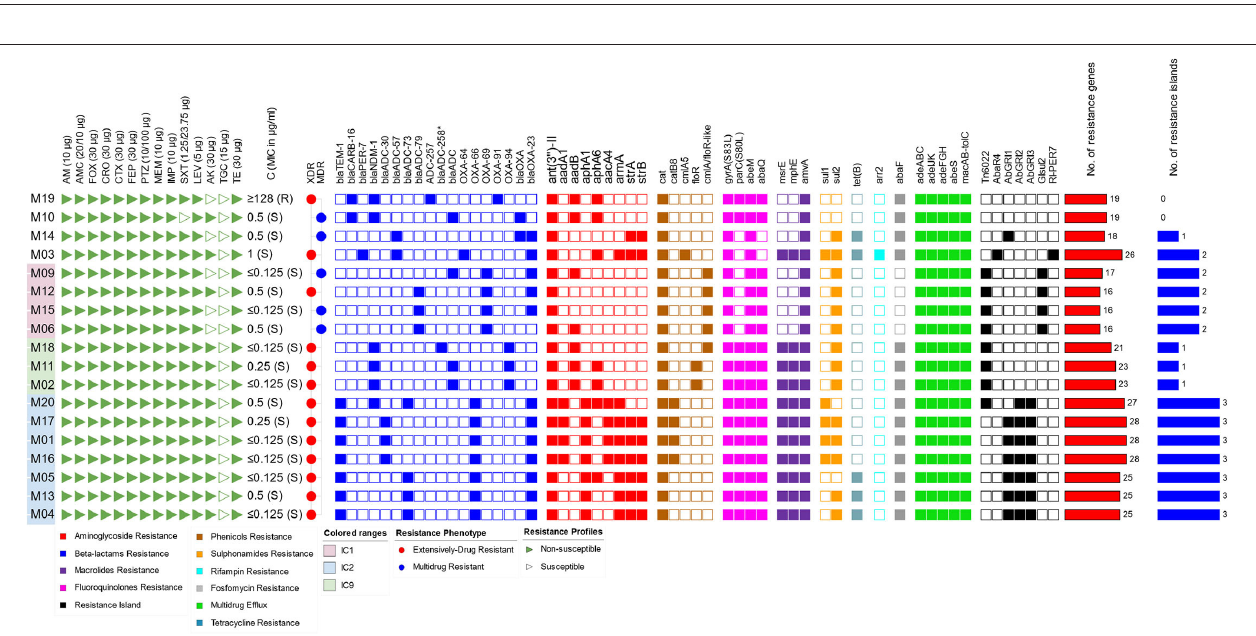
FIGURE 1 | SNP-based phylogenetic tree of A. baumannii draft genomes sequenced in the current study compared to other strains obtained from the NCBI and PubMLST databases. Labels of the A. baumannii strains sequenced in the current study are written in red. ST Pas , sequence type according to Pasteur scheme; ST Oxf , sequence type according to Oxford scheme; GC, global clone.